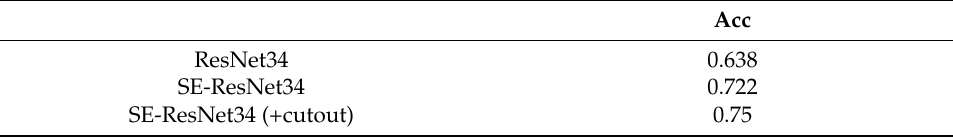
Table 3. The results of image classification on the testing